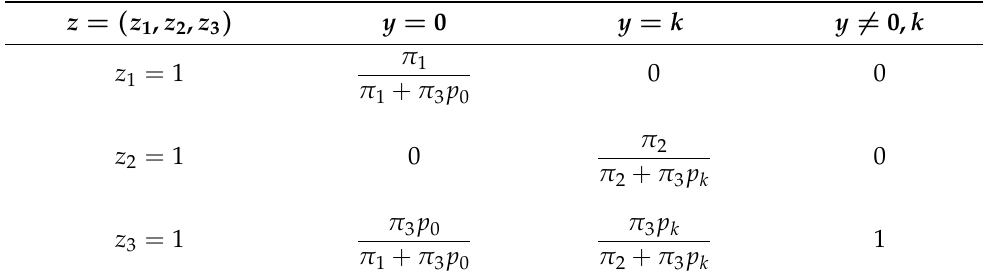
Table 1. P ( z = ( z 1 , z 2 , z 3 ) | Y = y ) of